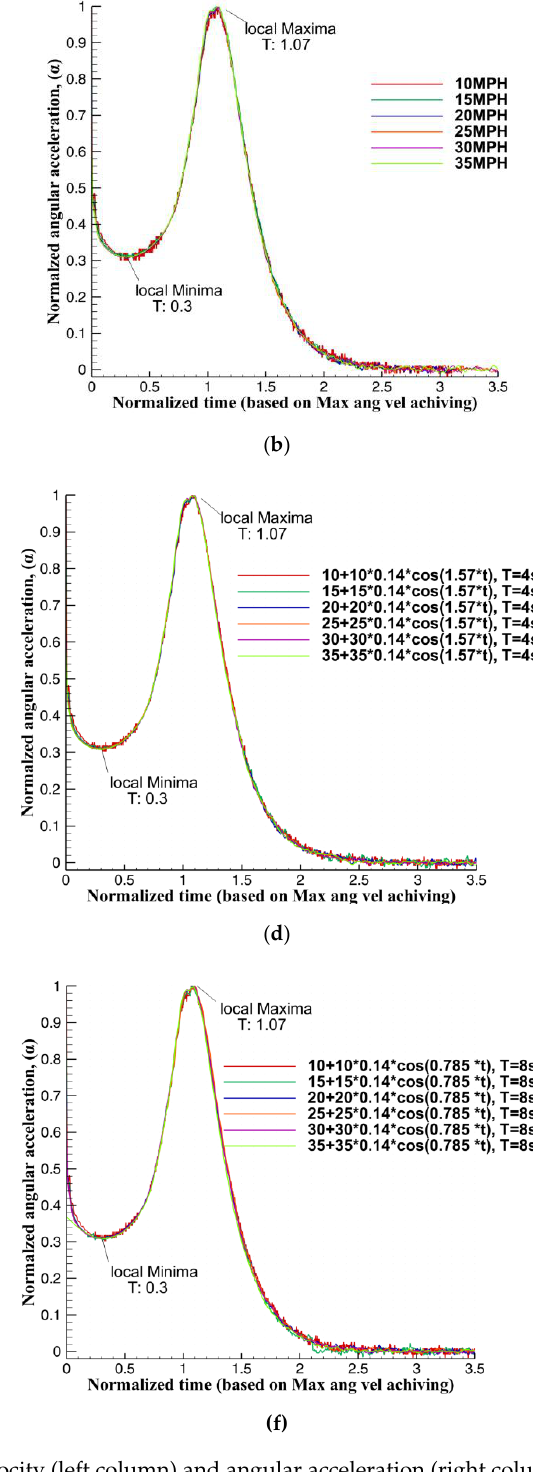
Figure 6. The evolution processes of the normalized angular velocity (left column) and angular acceleration (right column) of the rotor activated from stationary position by the various uniform wind fields. ( a , b ) Steady wind field; ( c , d ) periodic wind field, T = 4 s; ( e , f ) periodic wind field, T = 8